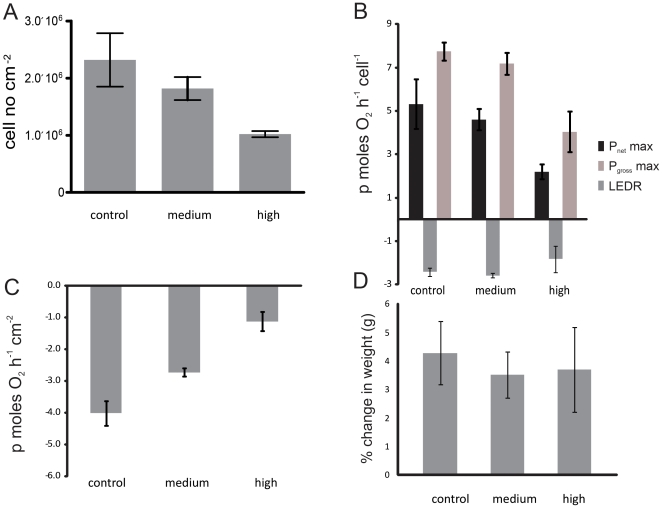
The effect of increasing CO2 in seawater (control, medium and high) after 28 days on coral-algal physiology.(A) Symbiodinium cell number in reef-building coral, Acropora millepora (B) photosynthetic capacity per symbiont cell measured as Pnet max, light enhanced dark respiration (LEDR), and Pgross max (Pnet max−LEDR) (C) dark respiration(R dark) and (D) relative calcification/growth as % change in weight (g) of coral branches over the 28 day experimental period. Error bars represent the standard error of the mean (n = 4).